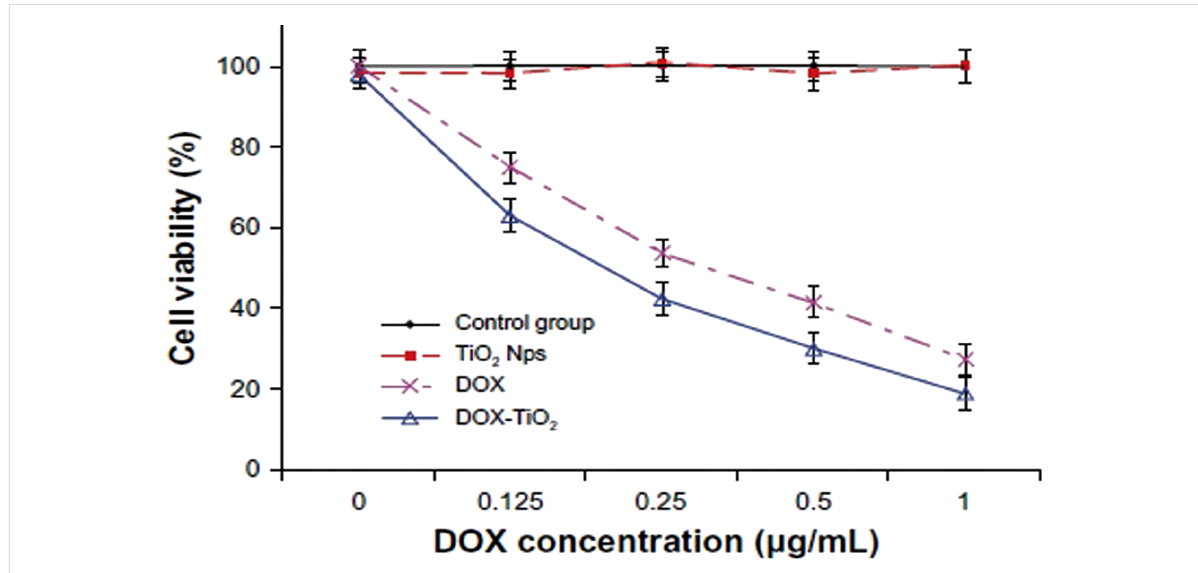
Figure 5: Cytotoxic effect of doxorubicin and DOX-TiO 2 nanocomposites against human SMMC-7721 hepatocarcinoma cells. Note: data expressed as the mean ± standard deviation ( n = 3). (Figure 5 was adapted from [108] “Anticancer efficacy enhancement and attenuation of side effects of doxorubicin with titanium dioxide nanoparticles”, © 2011 Y. Chen et al., published by Dove Medical Press Ltd.,